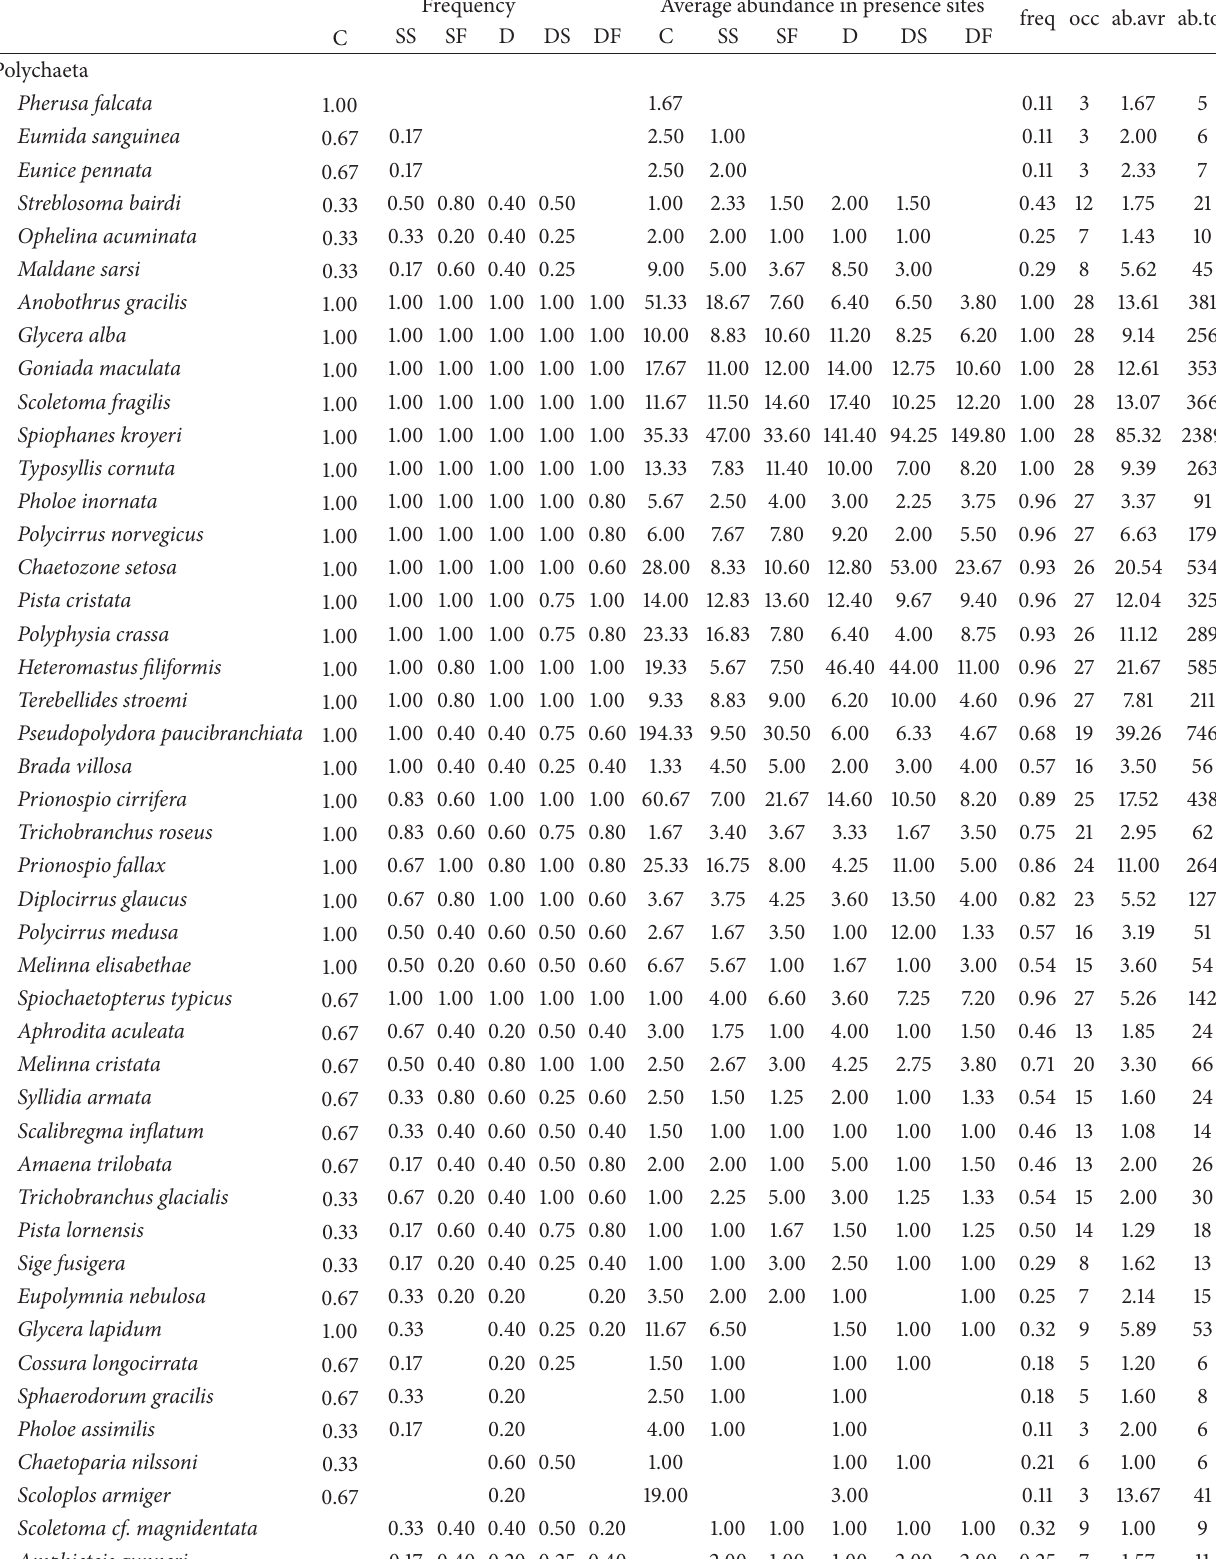
Table 4: Frequency and average abundance in presence sites per species as a function of affiliation to broad-scaled